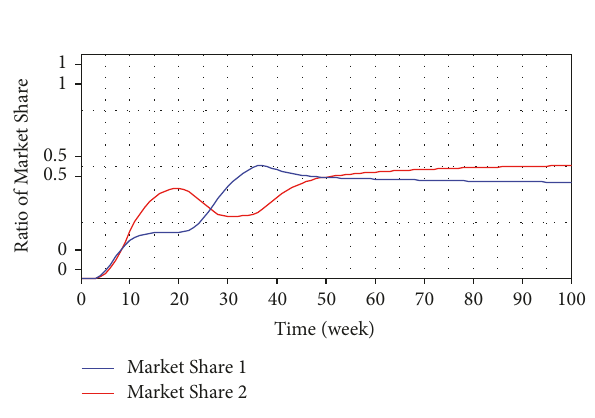
Figure 10: Market Share contrast